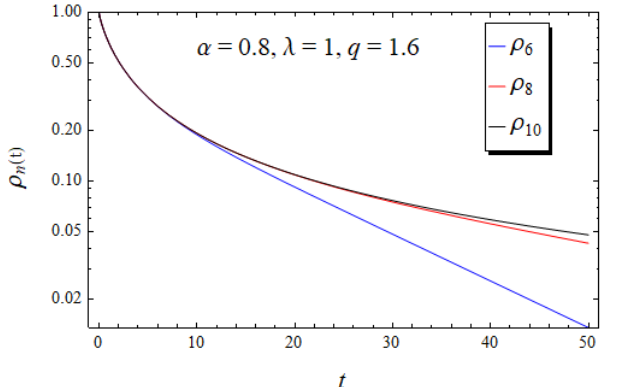
Figure 1. Logarithmic plot of the approximate solutions.